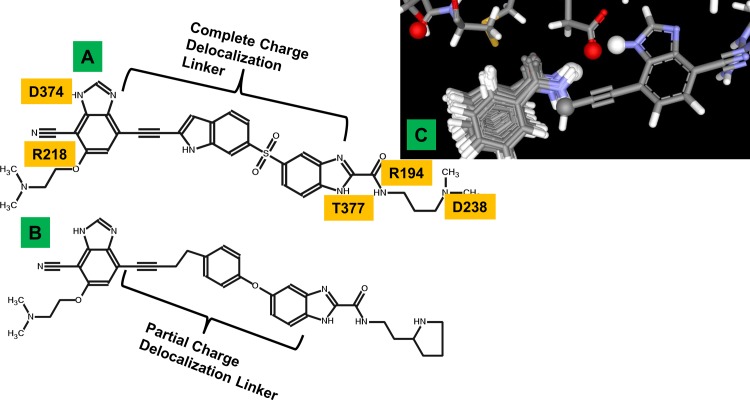
Complete vs. partial charge delocalization linkers.The molecule with a complete delocalization linker (A) was designed based on the benzaldehyde (C) and indole merging with acetylene predicted by SACP to also pincer D374. This linker strategy is based on connecting sites on the protein in a way that enables charge delocalization from D374 to R194. The partial delocalization linker (B) is designed to make the same interactions with PCSK as (A), so any difference in function provides evidence supporting our end-to-end charge delocalization conjecture.